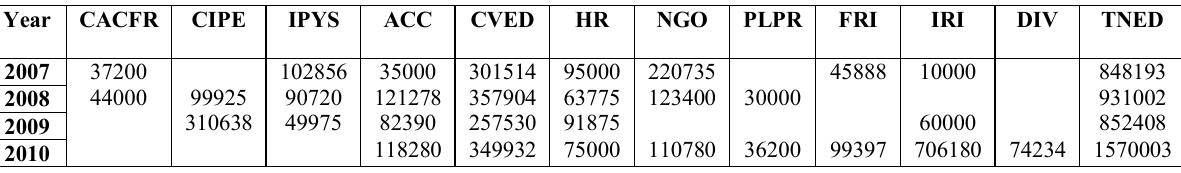
Table 3: Different heads of NED funding (in US $) for Venezuela